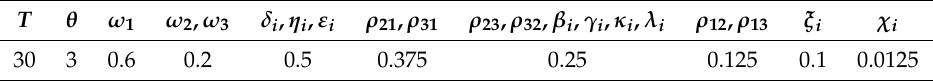
Table 2. Parameter values for an asymmetric monetary union, i =